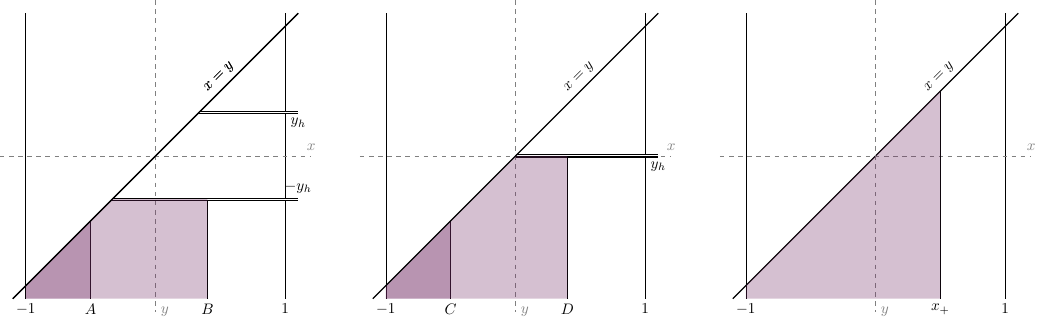
Figure 4 . Coordinate ranges for single-strut solutions constructed from metrics of Class I (with t timelike). Left : two qualitatively distinct solutions are shown for class I rapid , Centre: two for class I saturated , and Right : one for class I slow